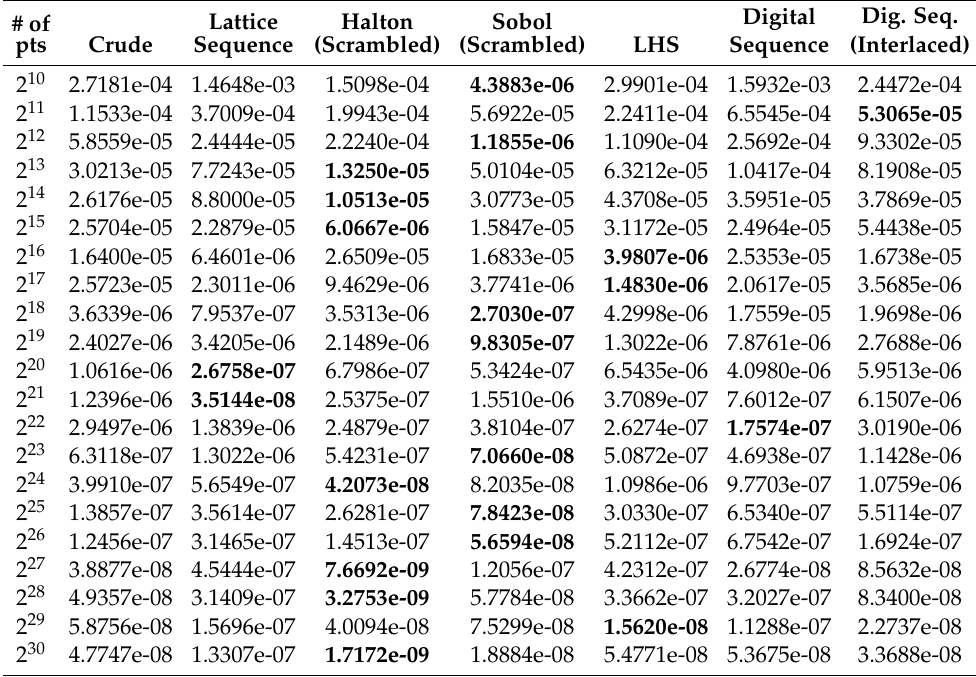
Dig. Seq. Digital Sequence (Interlaced)